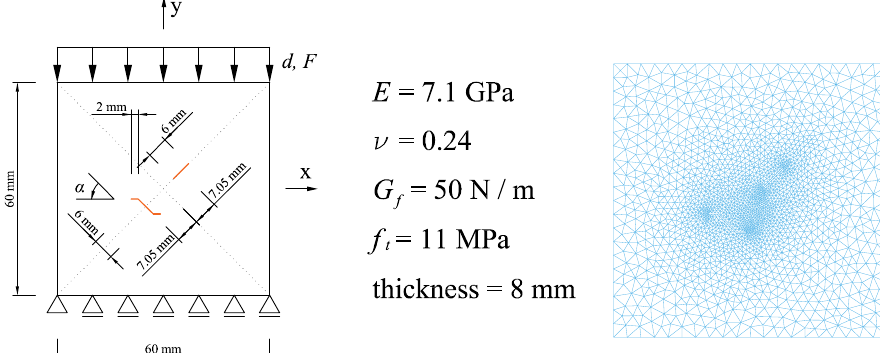
Figure 11. 3D-printed materials with two intermittent fissures: the model, material, and meshes.